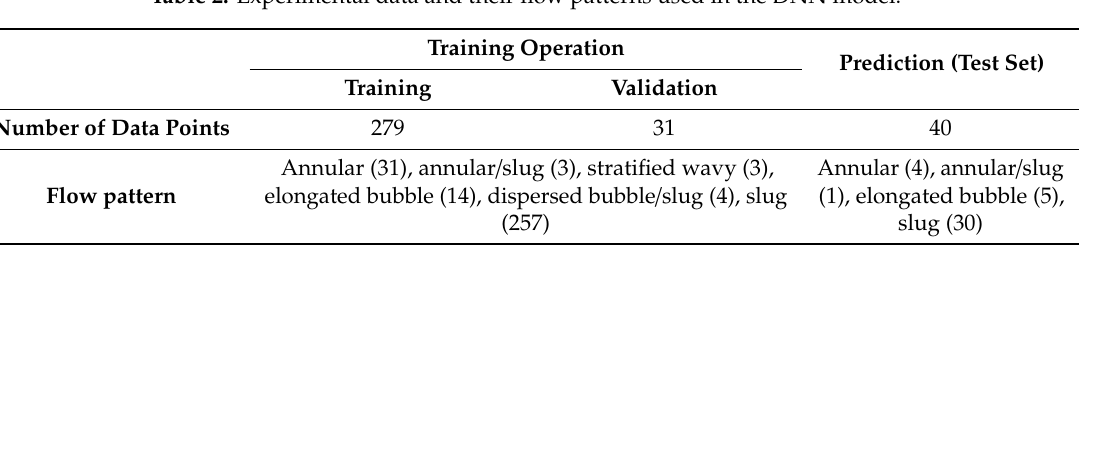
Table 2. Experimental data and their flow patterns used in the DNN